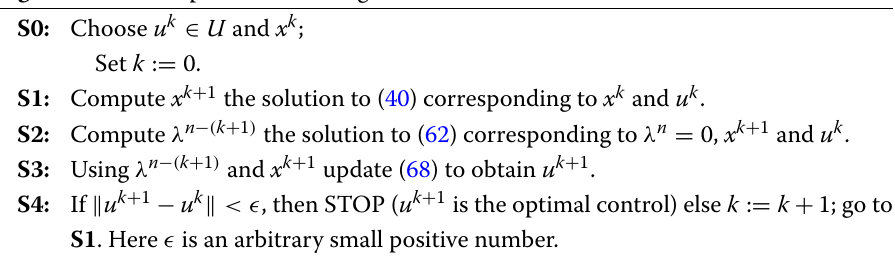
Algorithm 1 The optimal control